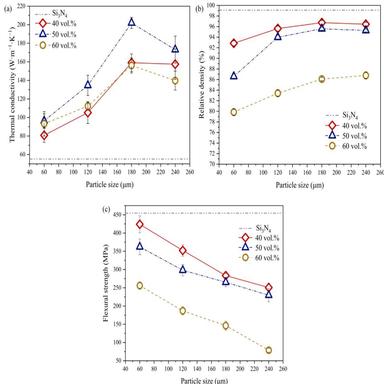
Properties of fabricated composites at different diamond particle content and size: (a) thermal conductivity, (b) relative density, and (c) flexural strength.